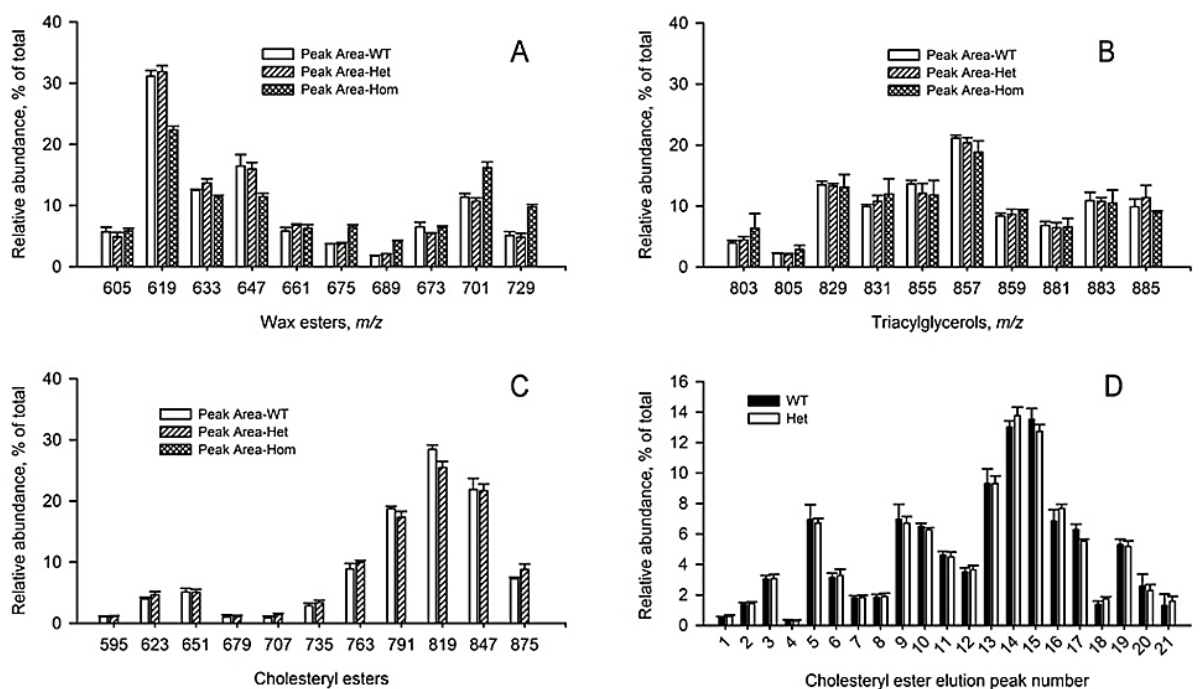
Figure 6. Targeted lipidomic analysis of wild-type ( n = 5), Soat1 +/− ( n = 7), and Soat1 −/− ( n = 5) mouse meibum. Normalized results are shown as mean ± standard deviation values. For each genotype in each of the panels, total sum of lipids equals 100%. ( A ) Wax esters, ( B ) triacylglycerols, and ( C ) cholesteryl esters analyzed as (M + H) + adducts; ( D ) cholesteryl esters analyzed as analytical ions m/z 369.35. The following assignments were made based on the m/z values and fragmentation patterns: C 10:0 (1); C 12:0 - and C 14:1 -CE (2); C 14:0 and C 16:1 (3); C 15:0 (4); C 16:0 - and C 18:1 -CE (5); C 17:0 -CE (6); C 18:0 - and C 20:1 -CE (7); C 19:0 -CE (8); C 20:0 - and C 22:1 -CE (9); C 21:0 -CE (10); C 22:0 - and C 24:1 -CE (11); C 23:0 -CE (12); C 24:0 - and C 26:1 -CE (13); C 25:0 -CE (14); C 26:0 - and C 28:1 -CE (15); C 27:0 -CE (16); C 28:0 - and C 30:1 -CE (17); C 29:0 (18); C 30:0 - and C 32:1 -CE (19); C 34:1 -CE (20); unidentified (21). A sample chromatogram with corresponding peak assignments is shown in Supplemental Figure S1. Structures of relevant mouse Meibomian gland lipids were established and reported in our earlier publications [7,12,14].